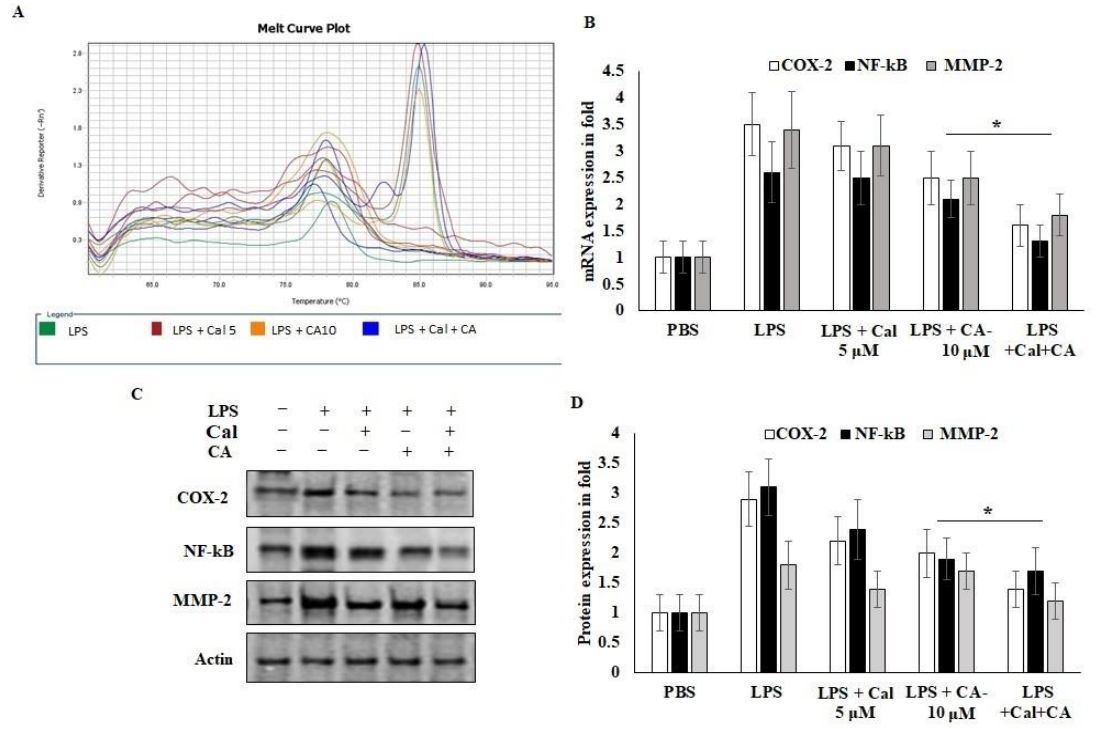
Figure 6. CA with Cal regulated the inflammatory and metastatic mediators of HCT116 colon cancer cell lines. A, B. mRNA expression of COX-2, NF- κB , MMP-2 and GAPDH was used as internal